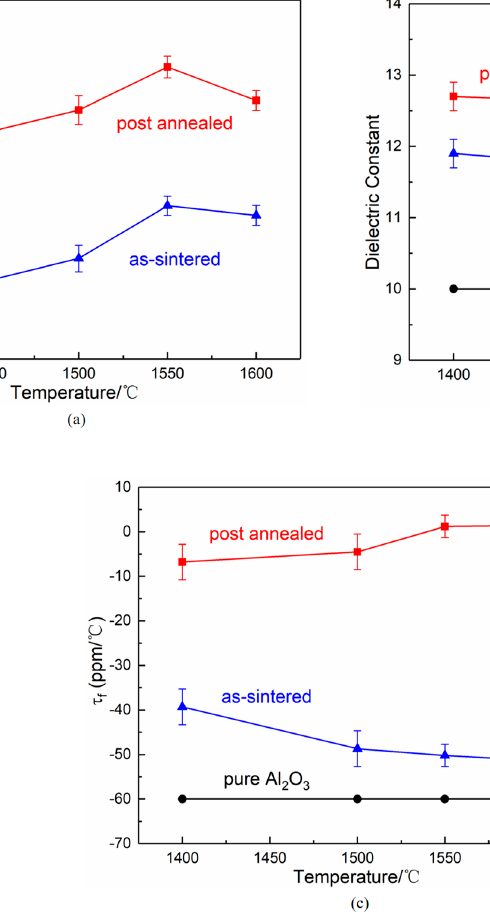
Figure 6. ( a ) Qf, ( b ) ε r , and ( c ) τ f , of 0.9 Al 2 O 3 -0.1 TiO 2 ceramics sintered at different temperatures for 2 h and annealed at 1000 ◦ C for 5 h. The results of pure Al 2 O 3 are also plotted in ( b , c ) for comparison [3]. Table 2. Microwave dielectric properties of 0.9 Al 2 O 3 -0.1 TiO 2 ceramics.